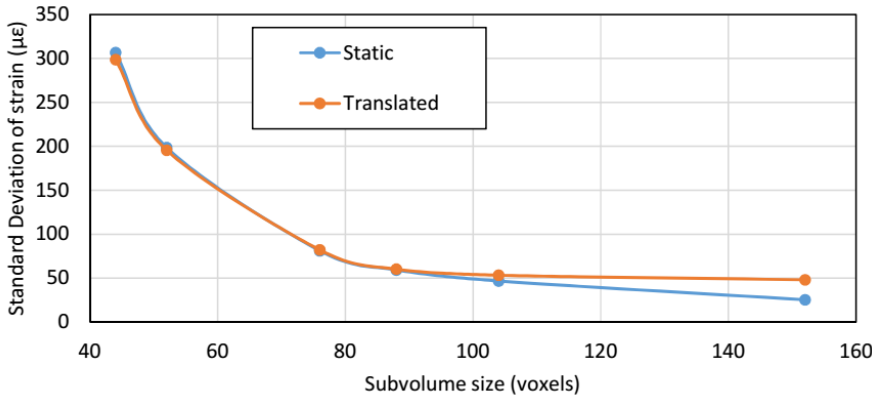
Figure 4. Influence of subvolume size on precision error between static and translated and scans.